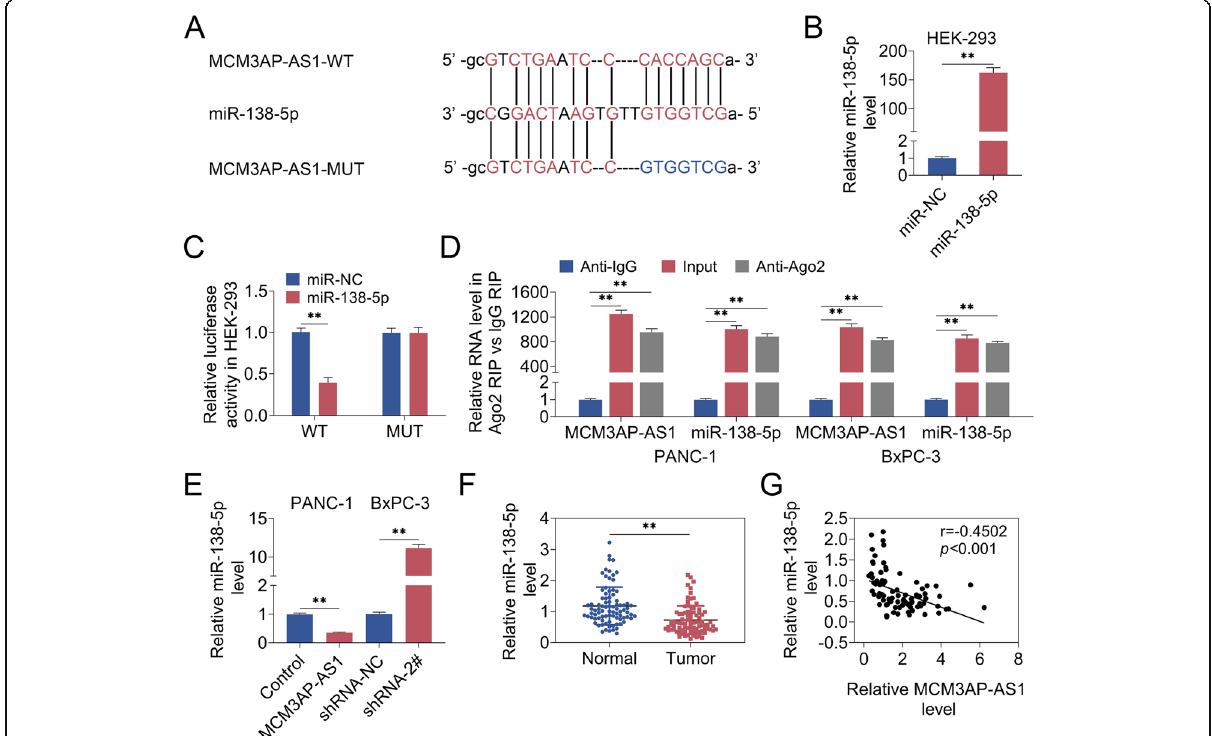
Fig. 4 MCM3AP-AS1 was negatively associated with miR-138-5p. a Bioinformatic analysis predicted that MCM3AP-AS1 could sponge miR-138-5p. b qRT-PCR detected miR-138-5p level. c Dual luciferase reporter assay demonstrated the interaction between MCM3AP-AS1 and miR-138-5p. d The binding of MCM3AP-AS1 and miR-138-5p was identified via RIP assay. e - f qRT-PCR analyzed miR-138-5p level. g The correlation between MCM3AP-AS1 and miR-138-5p was assayed. n = 3. (**, p <